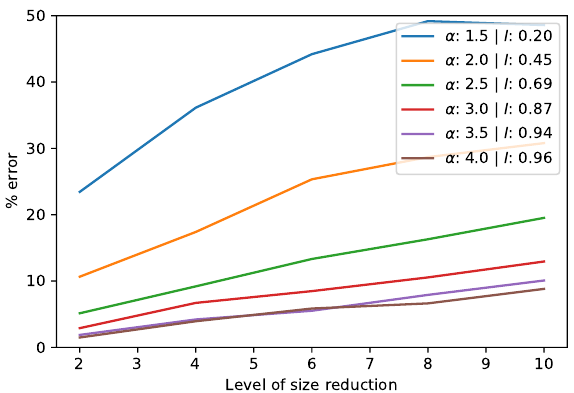
Figure 4. Error in the SVD of a coarsened spatial field for various α ’s and Moran’s I